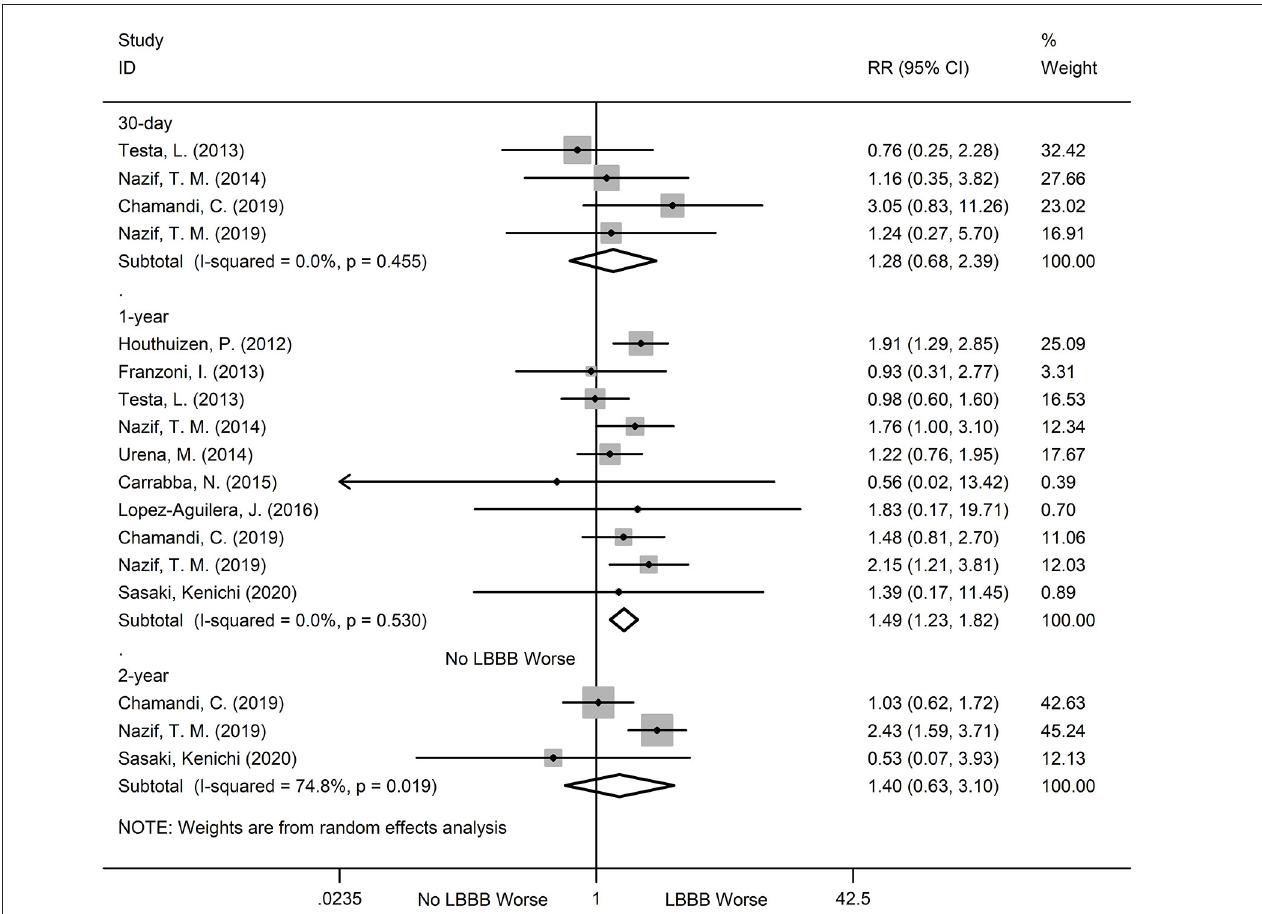
FIGURE 4 | Forest plot comparing cardiovascular mortality risk between patients with and without new-onset LBBB after